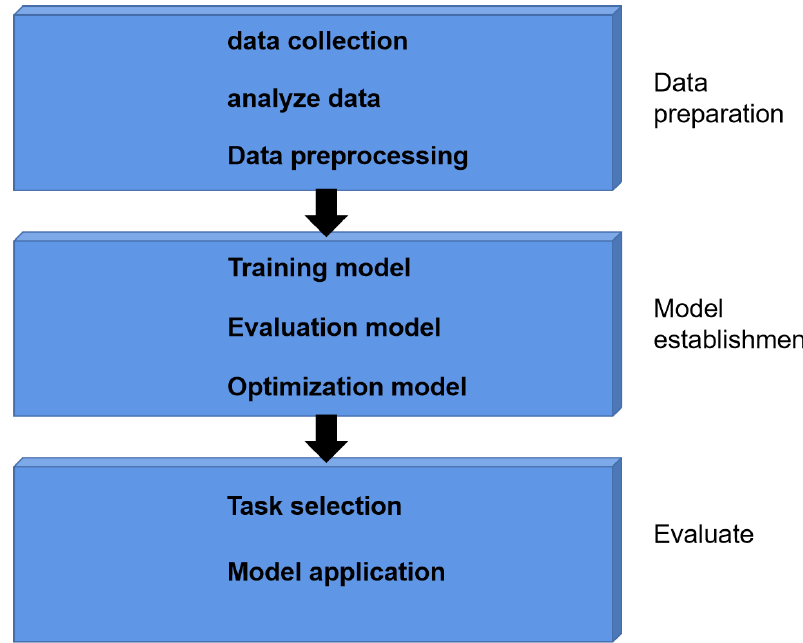
Figure 3. Abstract hierarchy of ML.